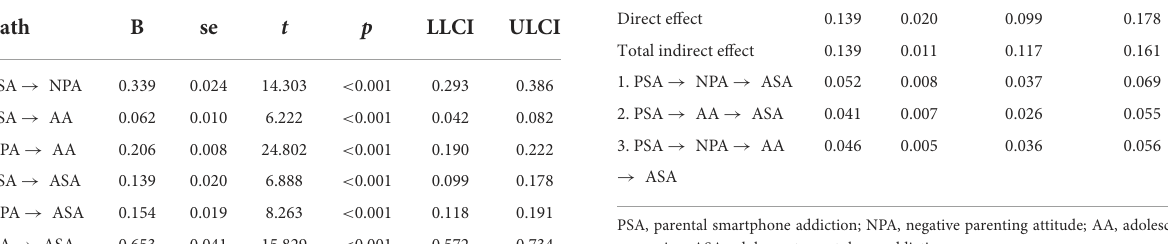
TABLE 3 Results of path analysis.